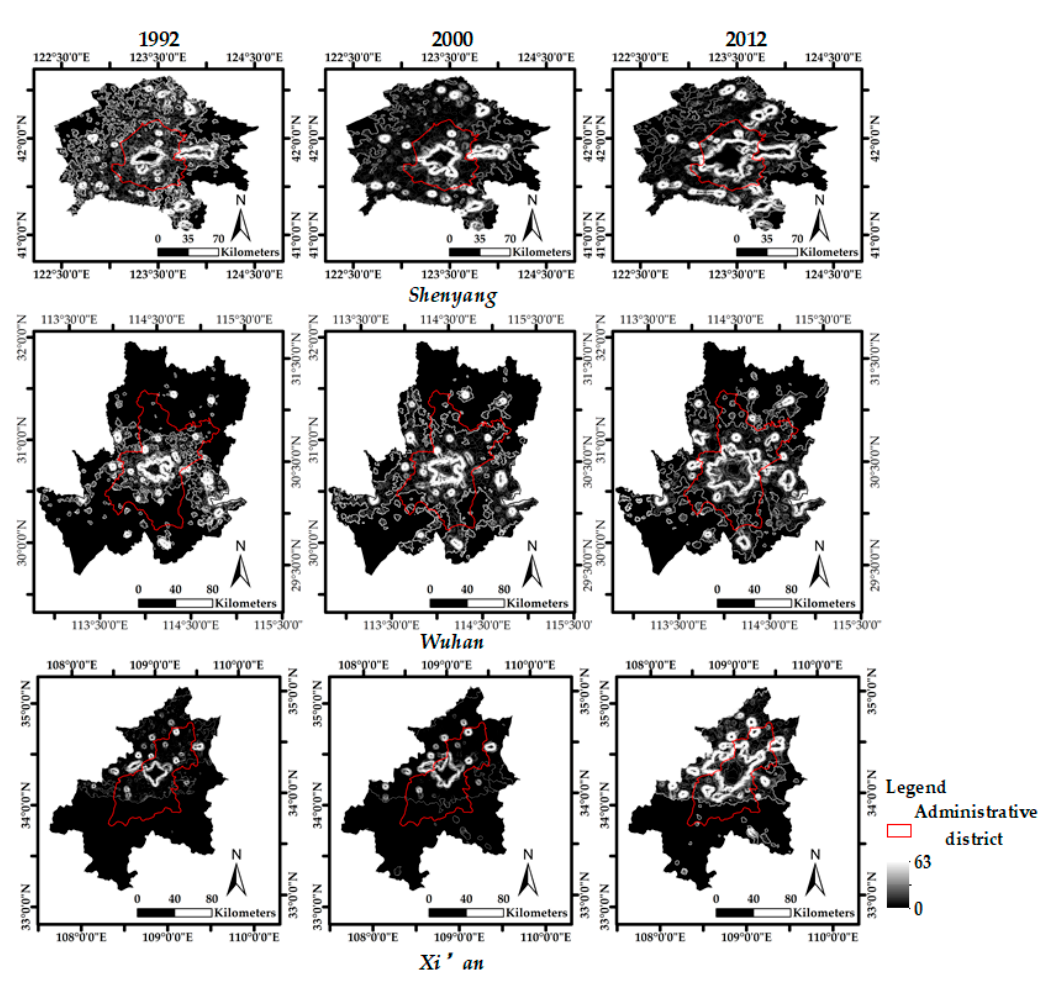
Figure 3. Gradient images of multitemporal DMSP/OLS data.